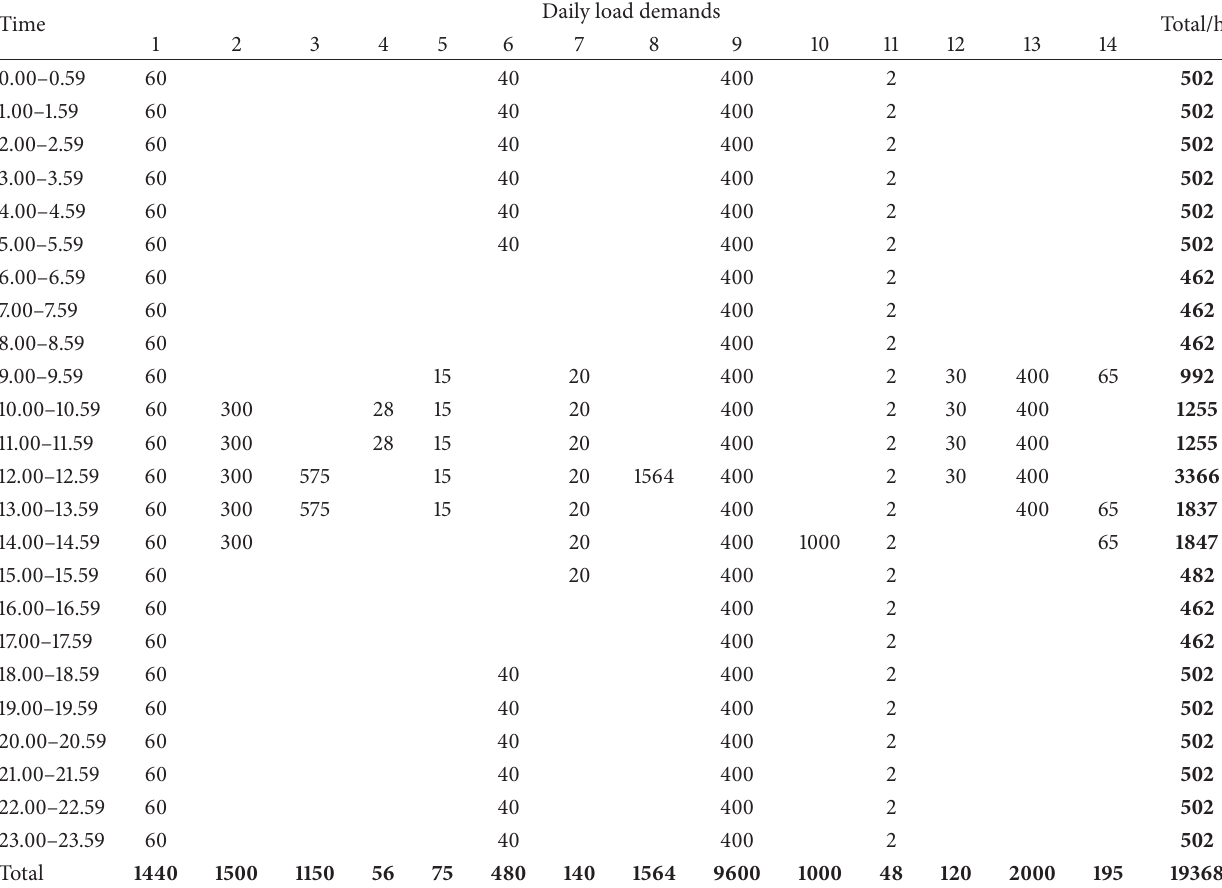
Table 2: The electrical load (daily load demands) data for a health